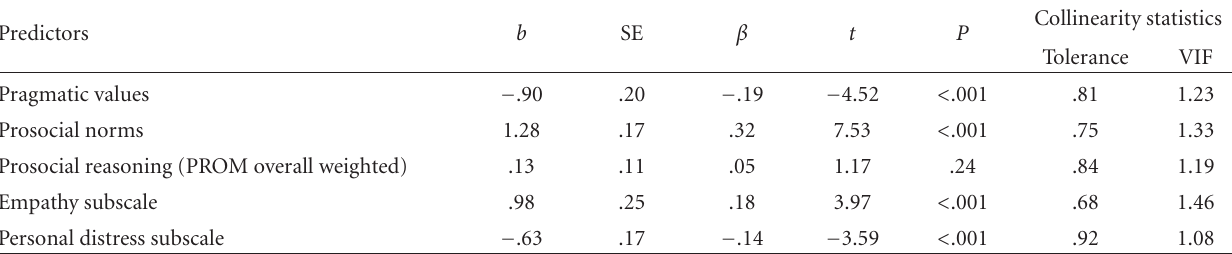
Table 3: Prediction of prosocial behavior (ABQ) among adolescents ( N = 516).